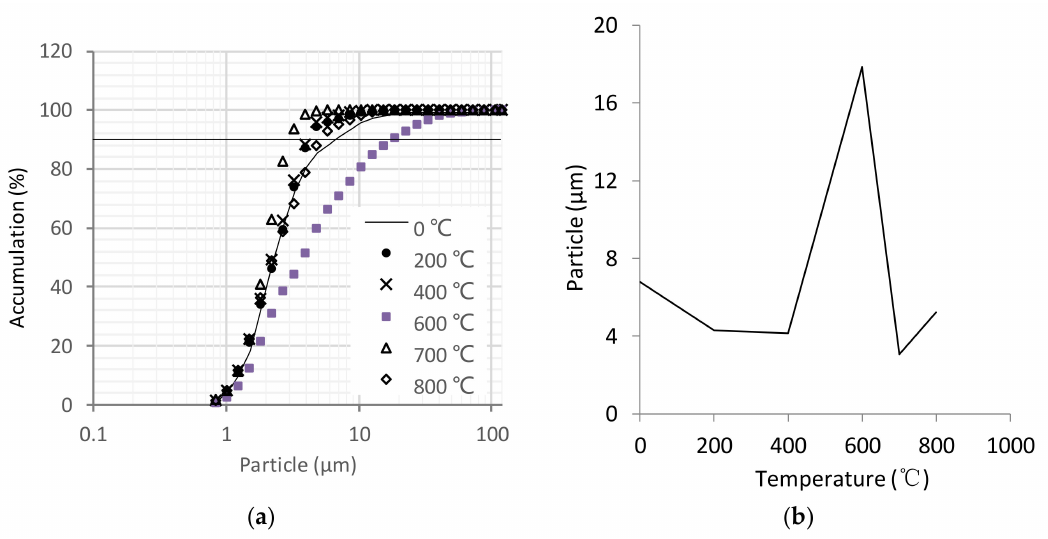
Figure 5. WCP particle analysis: ( a ) Accumulated particle size; ( b ) the particle size of 90% volume (D90).